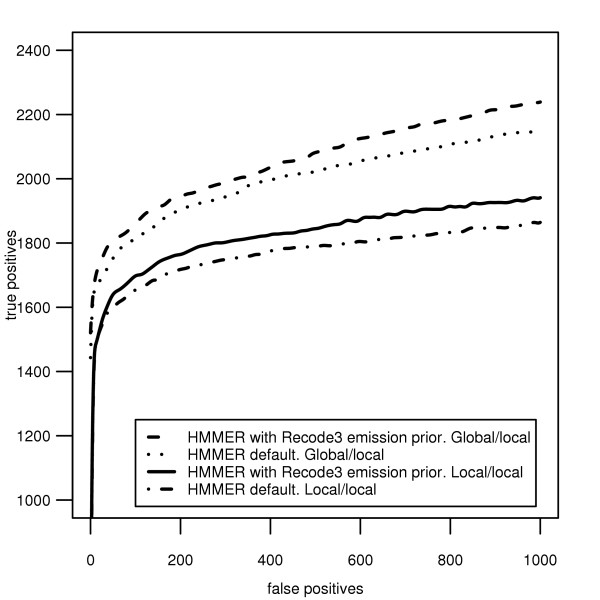
Analysis of emission prior probabilities. HMMER models were estimated using the SAM emission prior recode3.20.comp. Both local/local and global/local models were improved compared to using the HMMER default emission prior. Part of the SAM – HMMER performance difference can therefore be assigned to the emission prior.